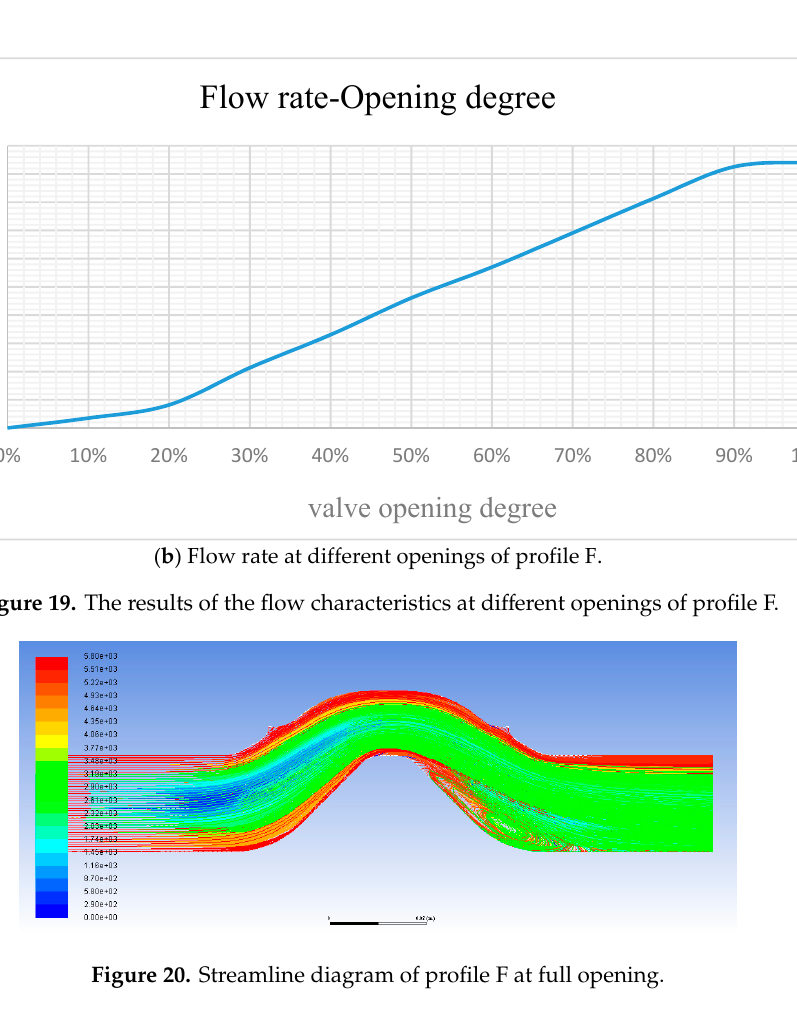
Figure 20. Streamline diagram of profile F at full opening.